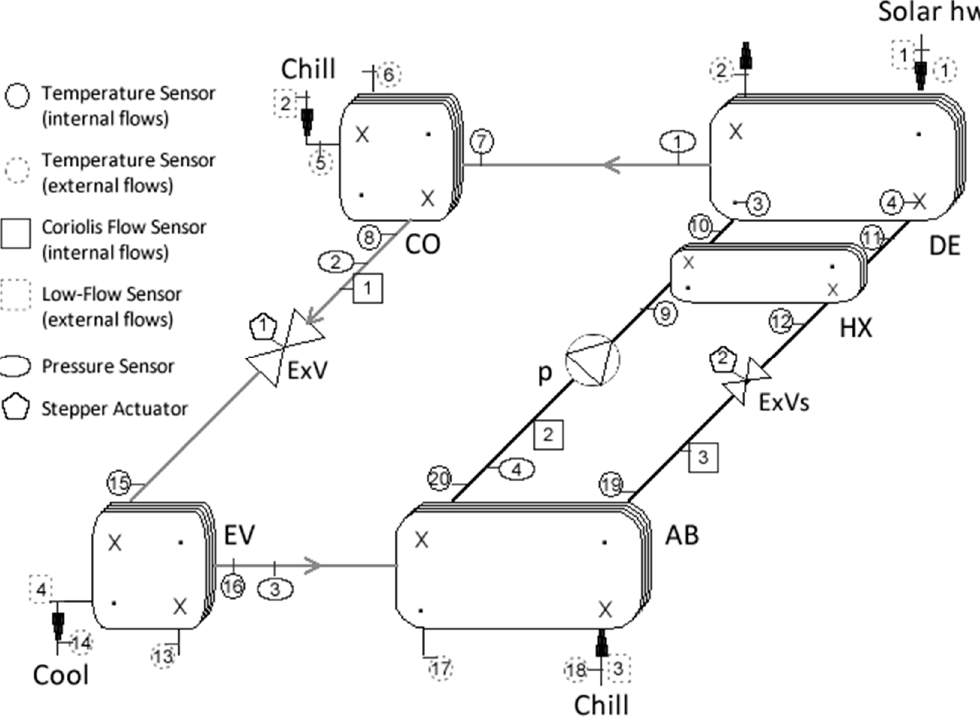
Figure 3. Sensors and actuators in the SACS.